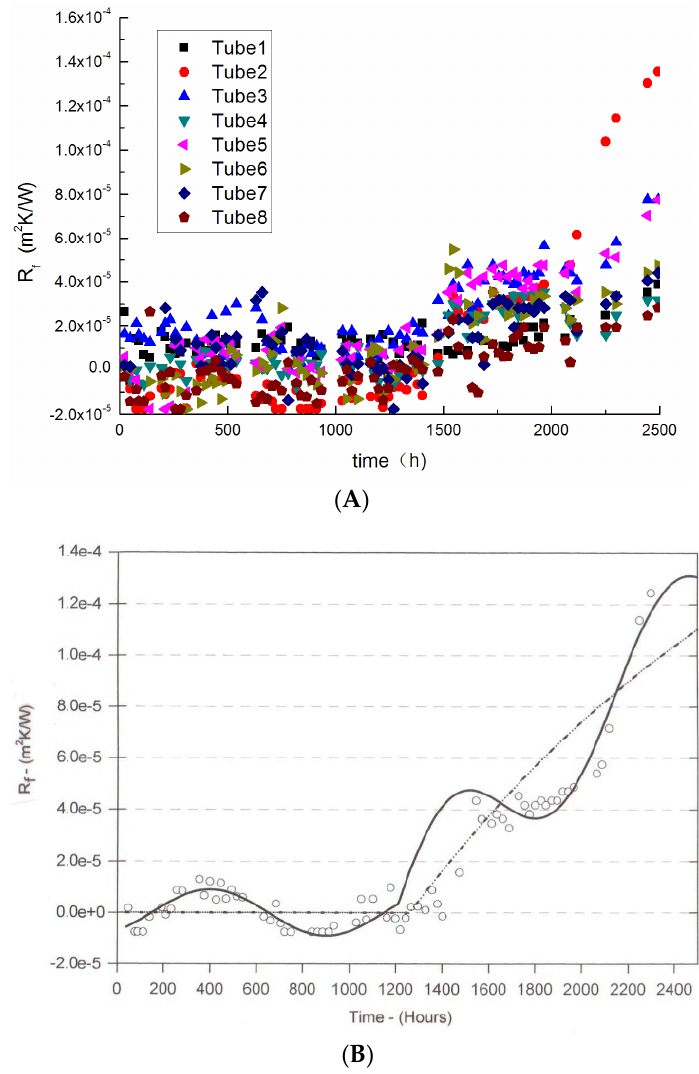
Figure 11. Cooling tower water fouling data [18]: ( A ) fouling data of the eight tested tubes, ( B ) fouling data and curve fits of fouled Tube 2.